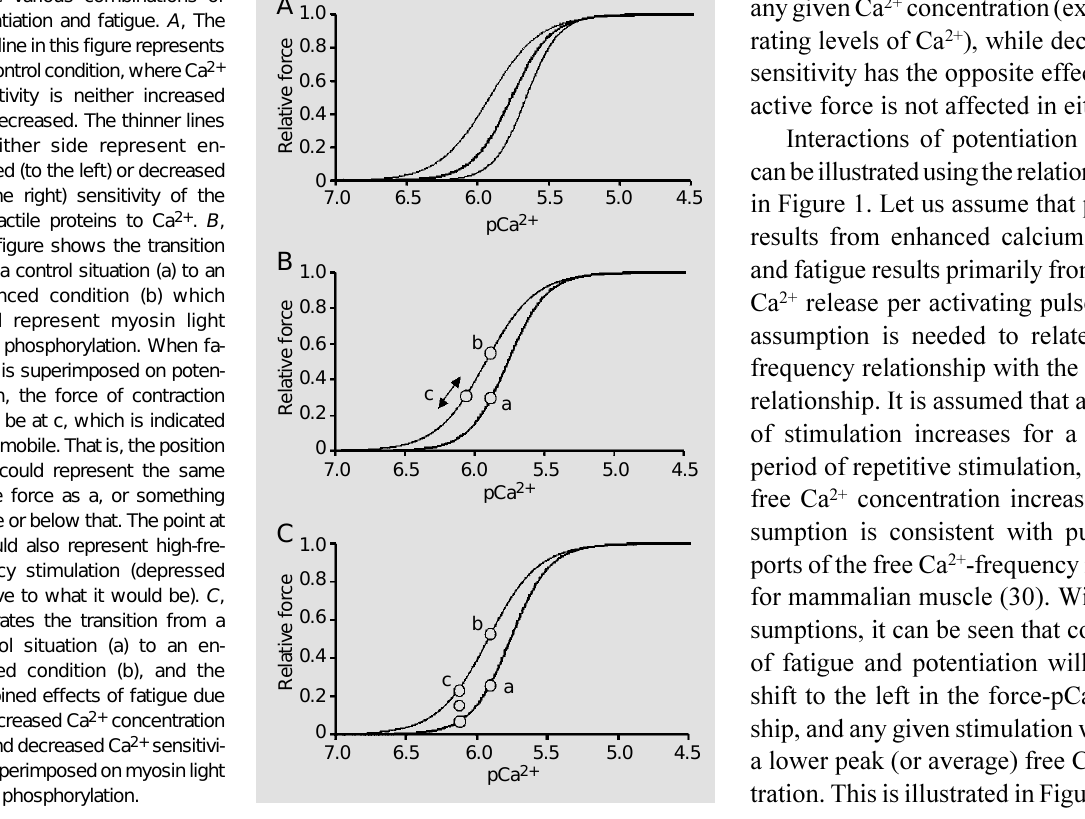
Figure 1 - Hypothetical force-cal- cium relationships which demon- strate various combinations of potentiation and fatigue. A , The thick line in this figure represents the control condition, where Ca 2+ sensitivity is neither increased nor decreased. The thinner lines on either side represent en- hanced (to the left) or decreased (to the right) sensitivity of the contractile proteins to Ca 2+ . B , This figure shows the transition from a control situation (a) to an enhanced condition (b) which could represent myosin light chain phosphorylation. When fa- tigue is superimposed on poten- tiation, the force of contraction could be at c, which is indicated to be mobile. That is, the position of c could represent the same active force as a, or something above or below that. The point at b could also represent high-fre- quency stimulation (depressed relative to what it would be). C , Illustrates the transition from a control situation (a) to an en- hanced condition (b), and the combined effects of fatigue due to decreased Ca 2+ concentration (c), and decreased Ca 2+ sensitivi- ty, superimposed on myosin light chain